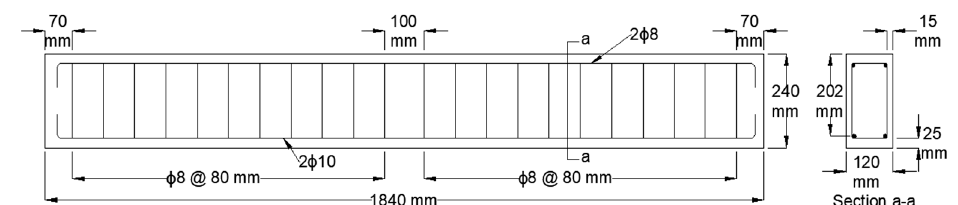
Figure 1. RC beam geometry and reinforcement details.